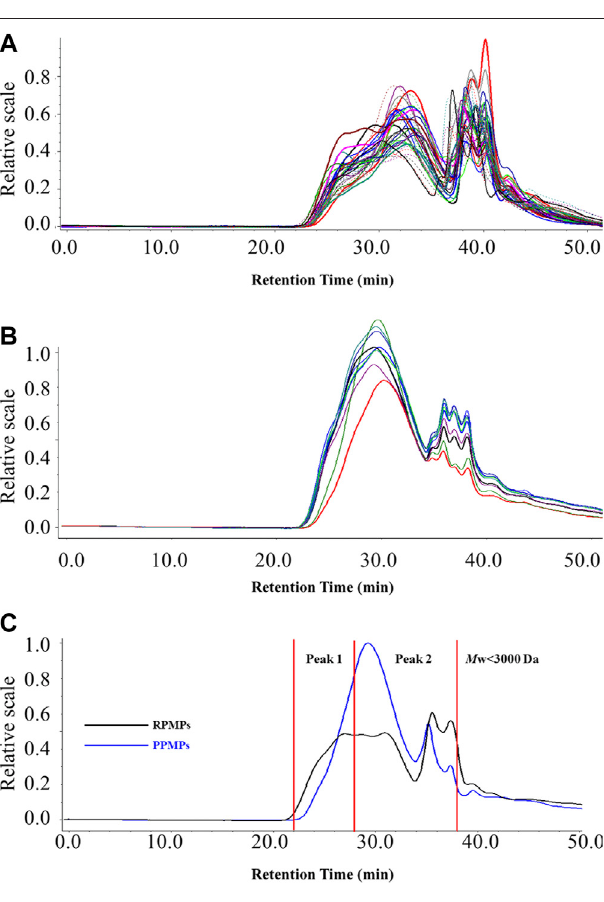
FIGURE 2 | The HPSEC-MALLS-RID chromatograms of 40 polysaccharide samples (A) RPMPs (B) PPMPs, and (C) the representative chromatograms of RPMPs and